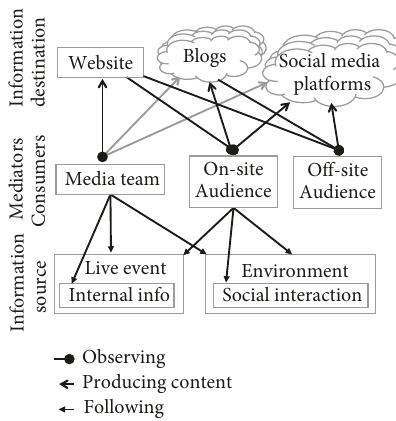
Figure 2: Emitting information (traditional env.).